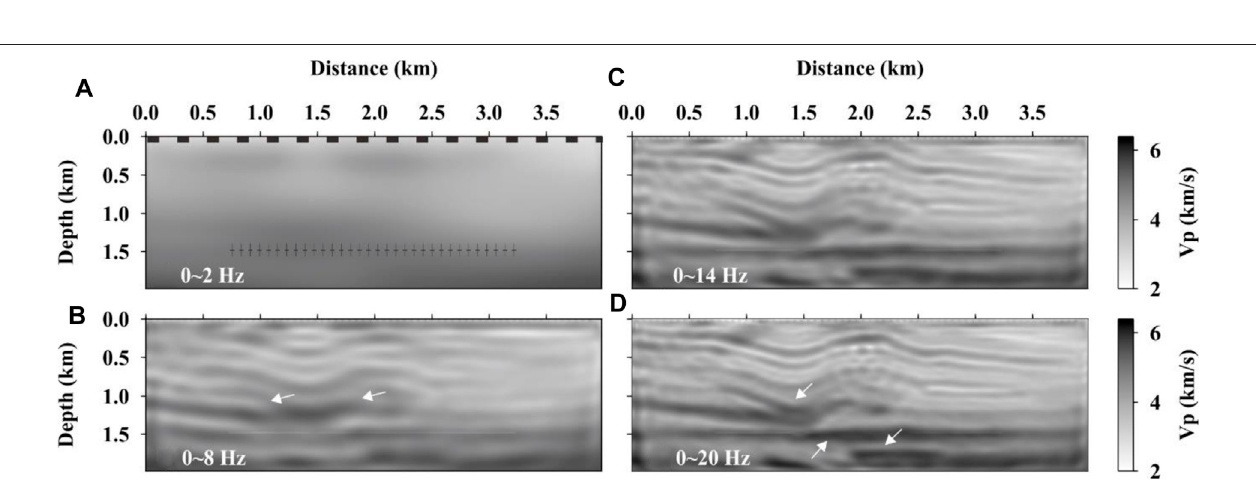
FIGURE5| InversionresultsofthePSdata. (A) Dashedlineofblackblocksatthetoprepresentsreceivers,andtheblackcrosssymbolsatthedepthlevelof1.5 km represent the perforations in the horizontal well. (A – D) Iterative inversion results of the frequency groups of 0 – 2, 0 – 8, 0 – 14, and 0 – 20 Hz, respectively.